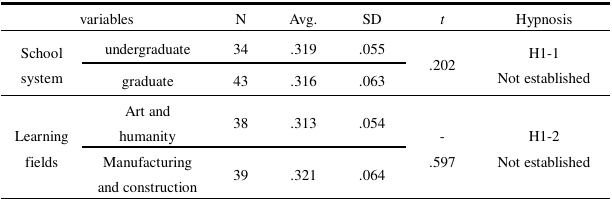
Table 7. Independent-sample t test of